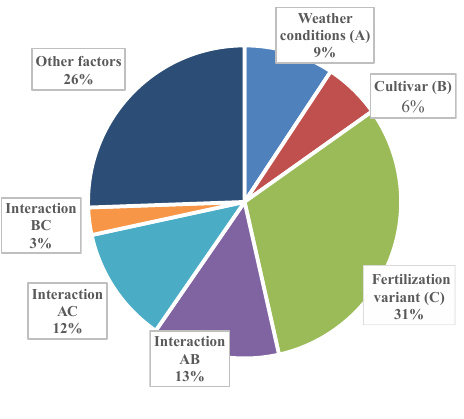
Figure 5 e factors affecting the productivity tillering formation of the wheat cultivars’